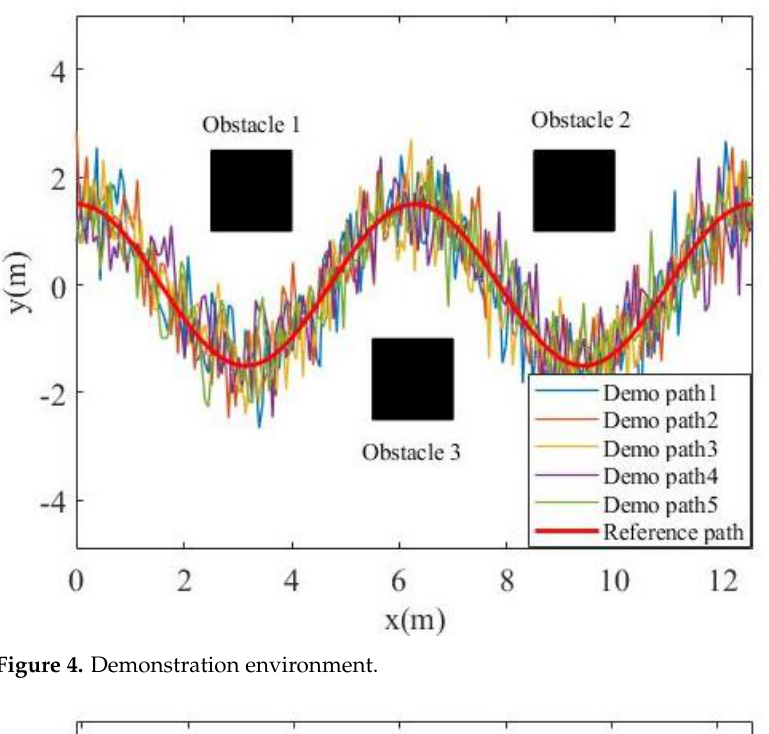
Figure 4. Demonstration environment.